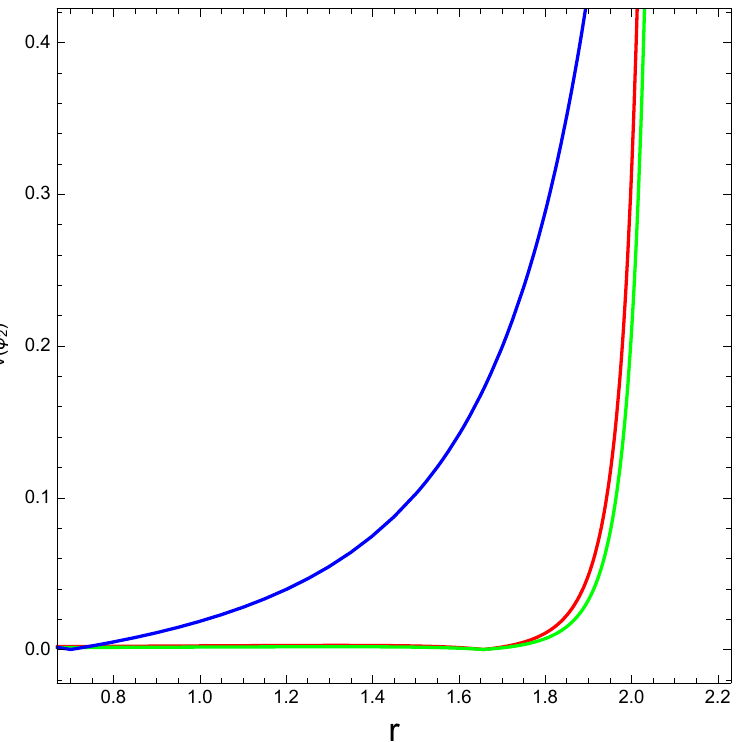
Figure 18. Solution of the scalar potential for R adopted as a linear function of radius. The evolution of the scalar potential V ( φ 2 ) is obtained by comparing Equation (8) and Equation (32). We have fixed the values of a 0 , a 1 , a 2 , K , and C 1 . The red, green, and blue lines correspond to small perturbations of λ 0 , Ψ 0 , η 1 , η 2 , and η 3 ,